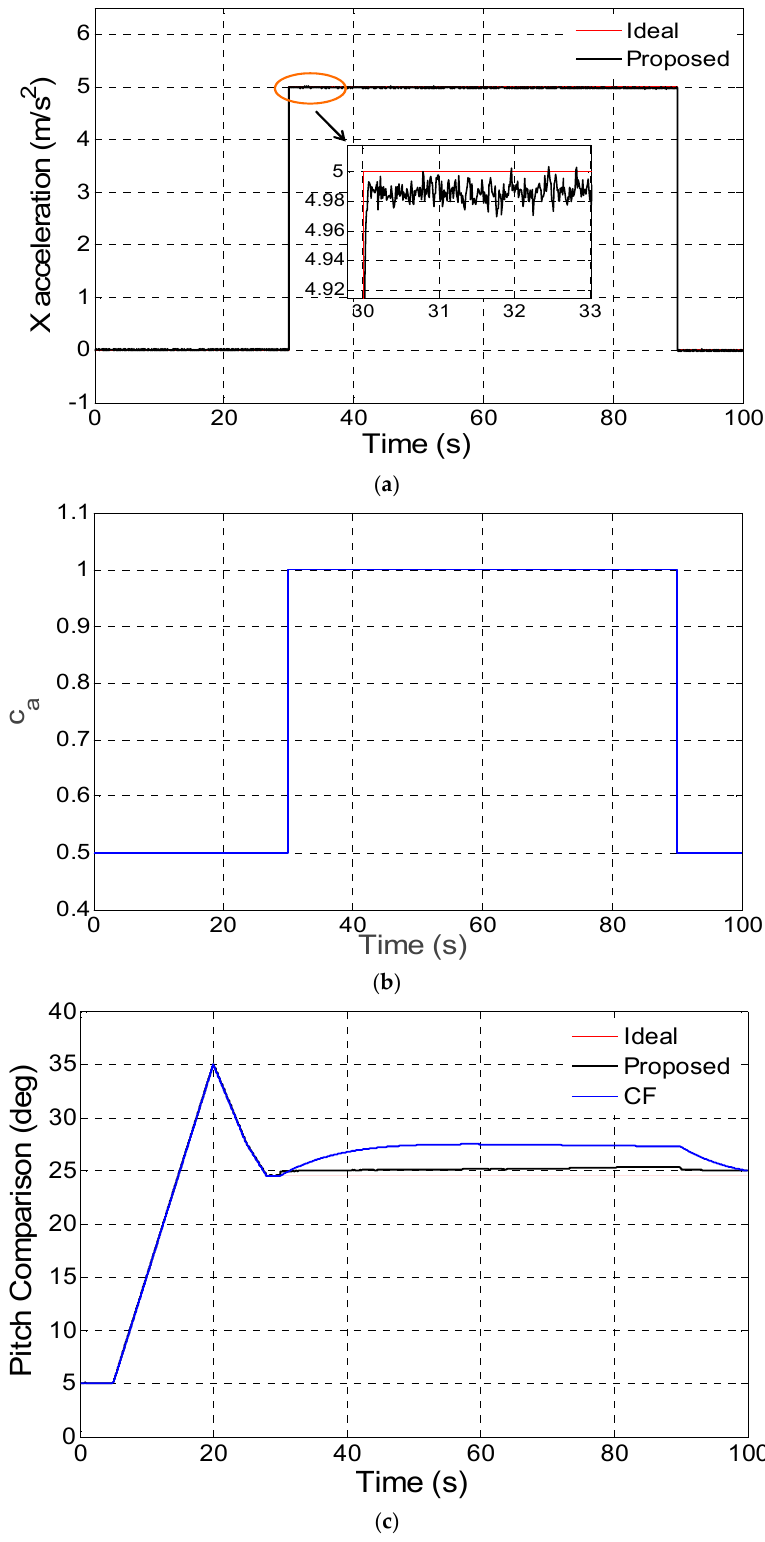
Figure 5. ( a ) X axis disturbance acceleration estimation on body frame in sustained-acceleration mode; ( b ) Adaptive switch for c a in sustained-acceleration mode; ( c ) Pitch estimate comparison in sustained-acceleration mode.